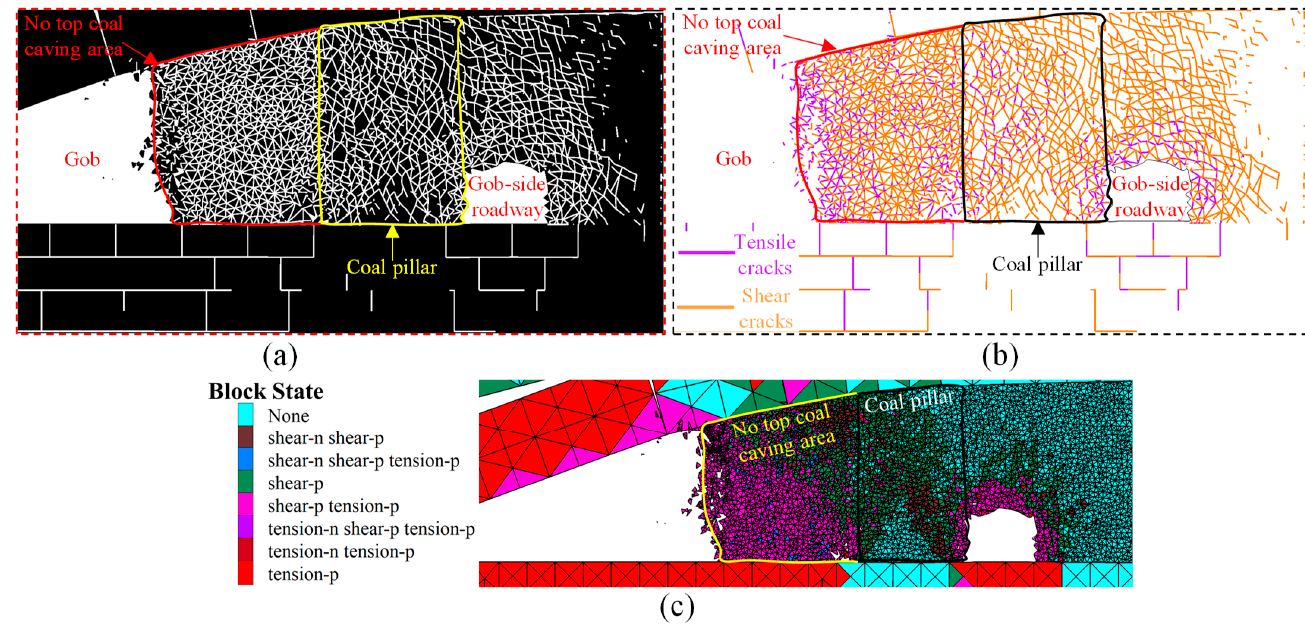
Figure 22. Development state of coal pillar fracture of gob-side entry driving in fully mechanized caving: ( a ) fracture pattern, ( b ) cracks, and ( c ) state. caving: ( a ) fracture pattern, ( b ) cracks, and ( c )